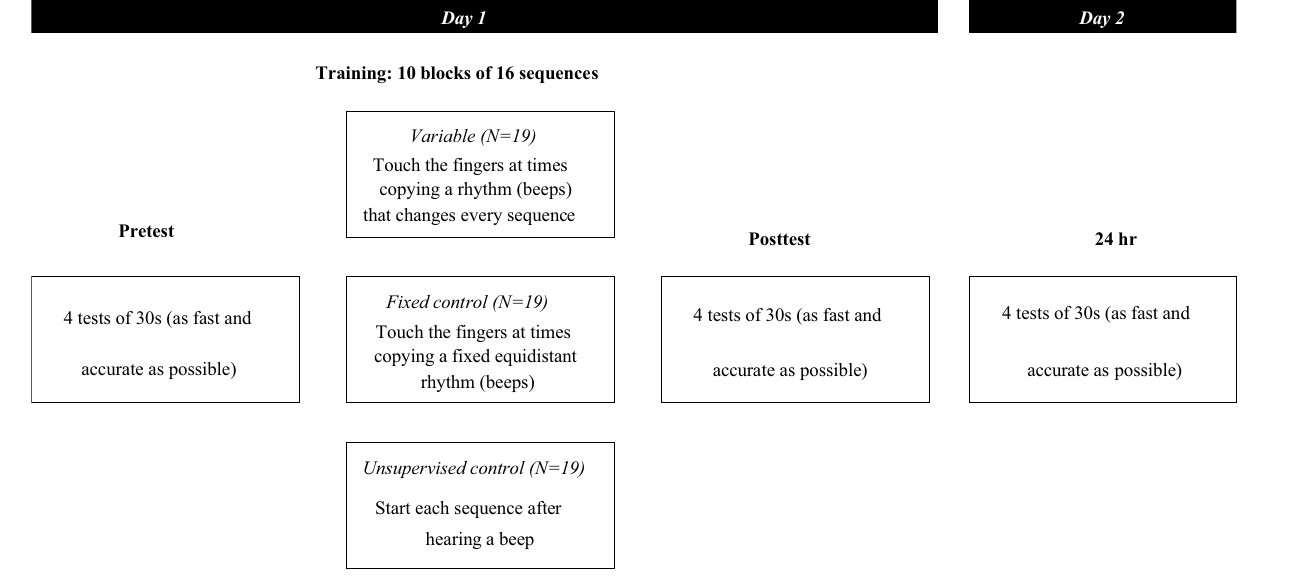
Figure 6. Experimental protocol. The groups differed only during the training.